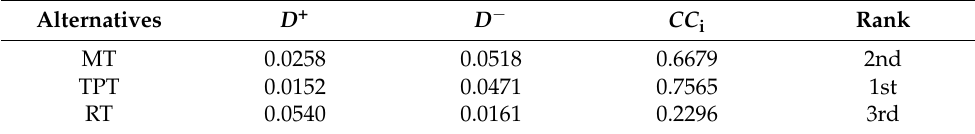
Table 9. Distances to ideal solution and closeness